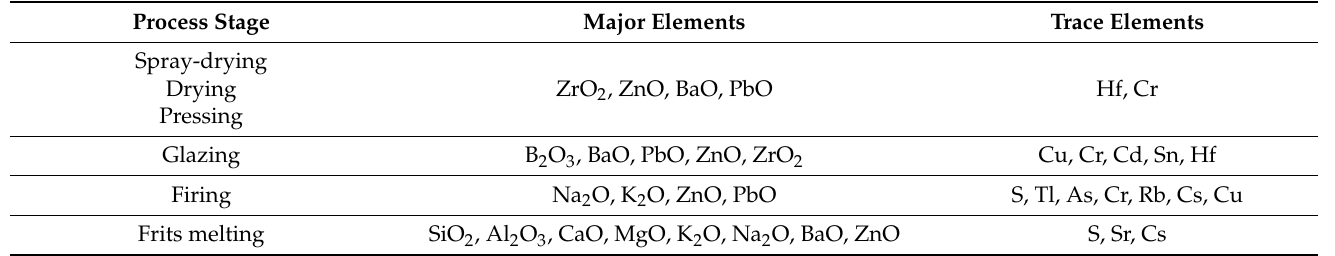
Table 8. PM emission composition (major and trace elements) associated with different ceramic process